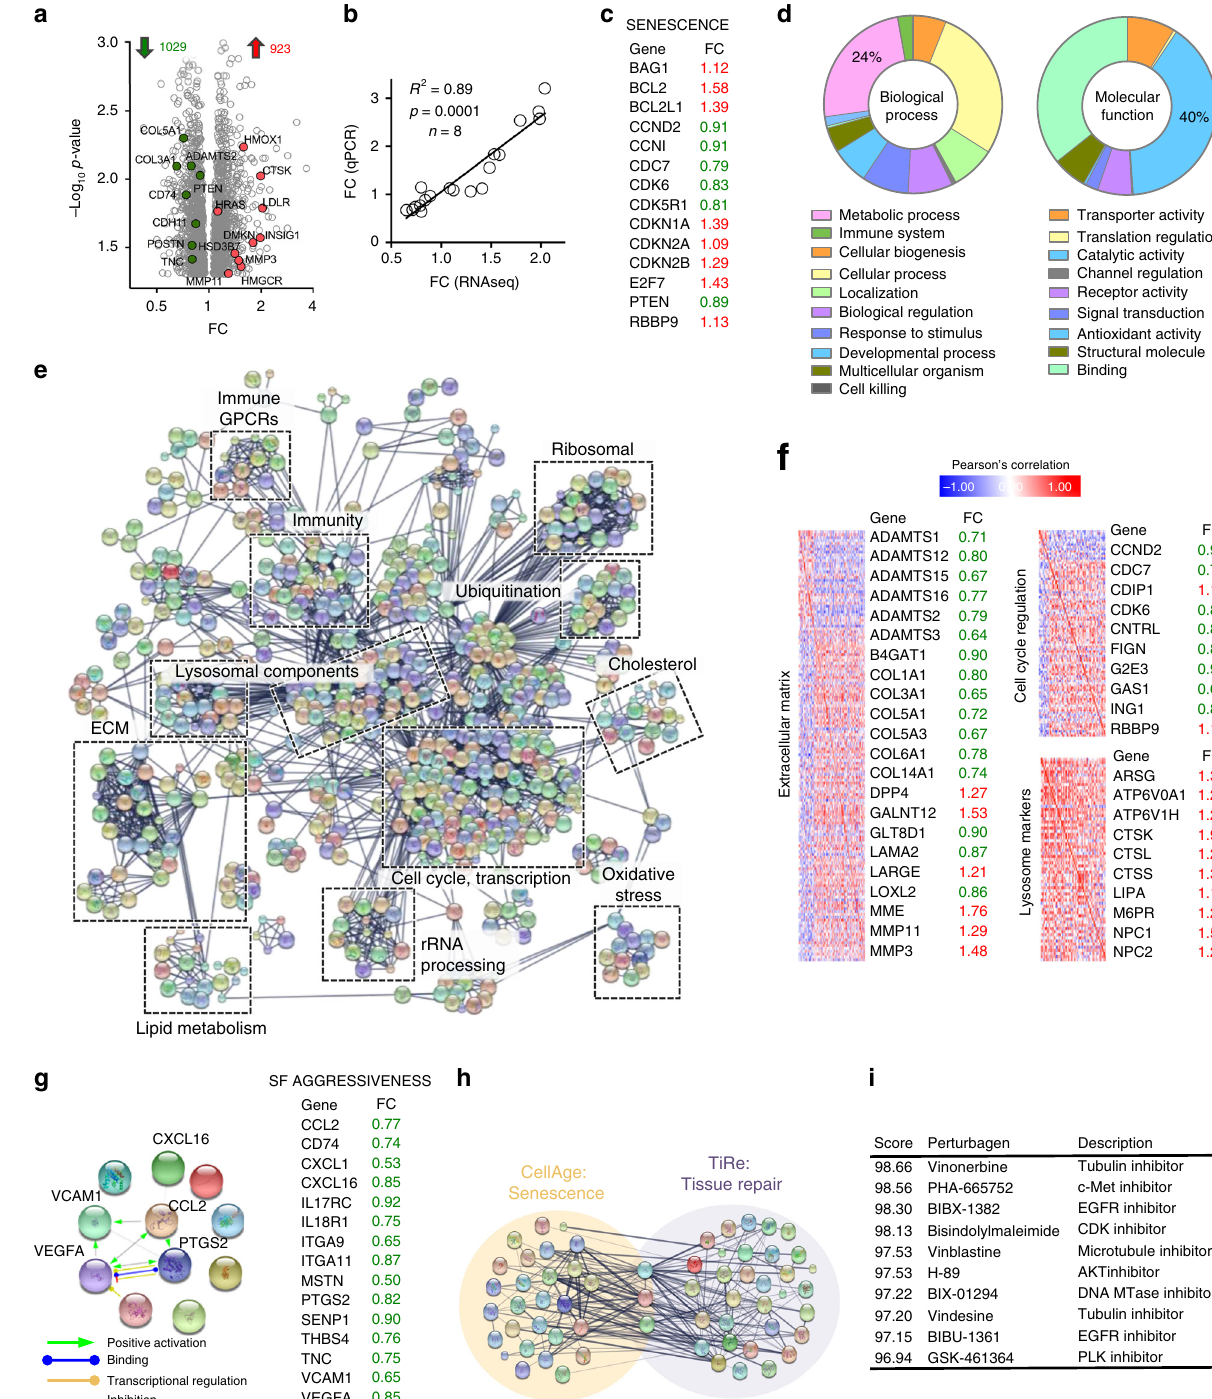
MC 1 -mediated senescence leads to a tissue repair pro fi le . Senescence is often associated with a speci fi c secretory phenotype called SASP, which typically includes cytokines. However, the SASP induced by BMS on RA SF did not exhibit this pro-in fl ammatory phenotype, as levels of CCL-2, IL-6, or IL-8 were reduced (Sup- plementary Fig. 1K). To fully elucidate the phenotype acquired by BMS-induced senescence in SF, we conducted RNA sequencing analysis. SF were treated with BMS (using the 7-day incubation protocol) and subjected to whole-genome RNA sequencing. This